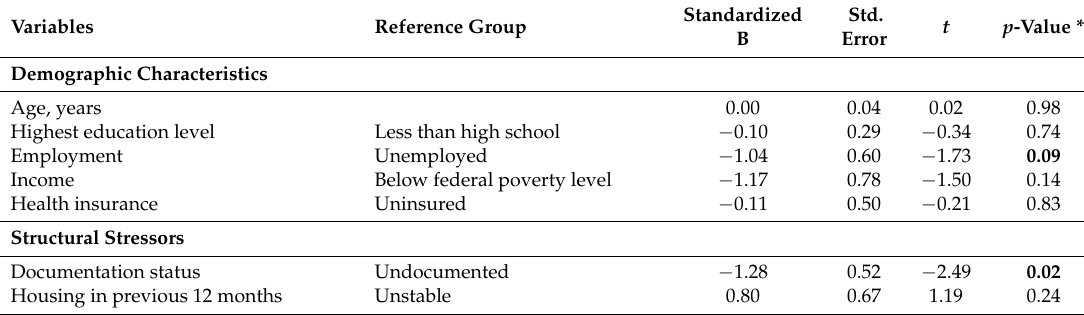
Table A1. Bivariate Associations with Depressive Symptoms among Immigrant Latina Transgender Women in the STROBE Study, Washington, DC, USA,